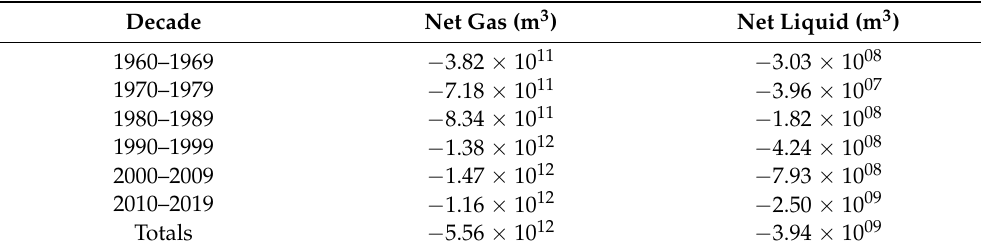
Table 2. Calculated decade-level variations in net industrial fluid injection and production stock-tank volumes in the Alberta Basin. Source data extracted from geoLOGIC Systems databases ©